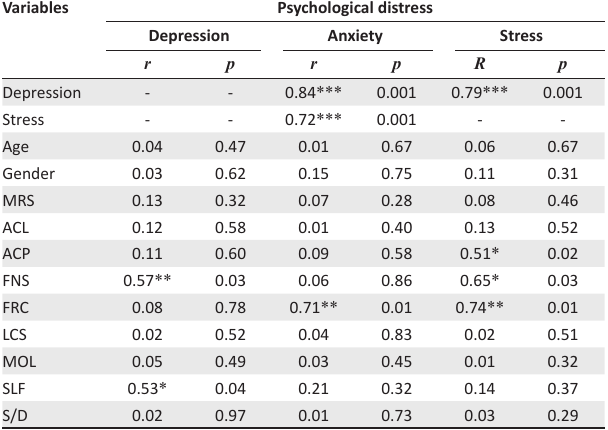
TABLE 5: Correlation among psychological symptoms and predictor variables. Variables